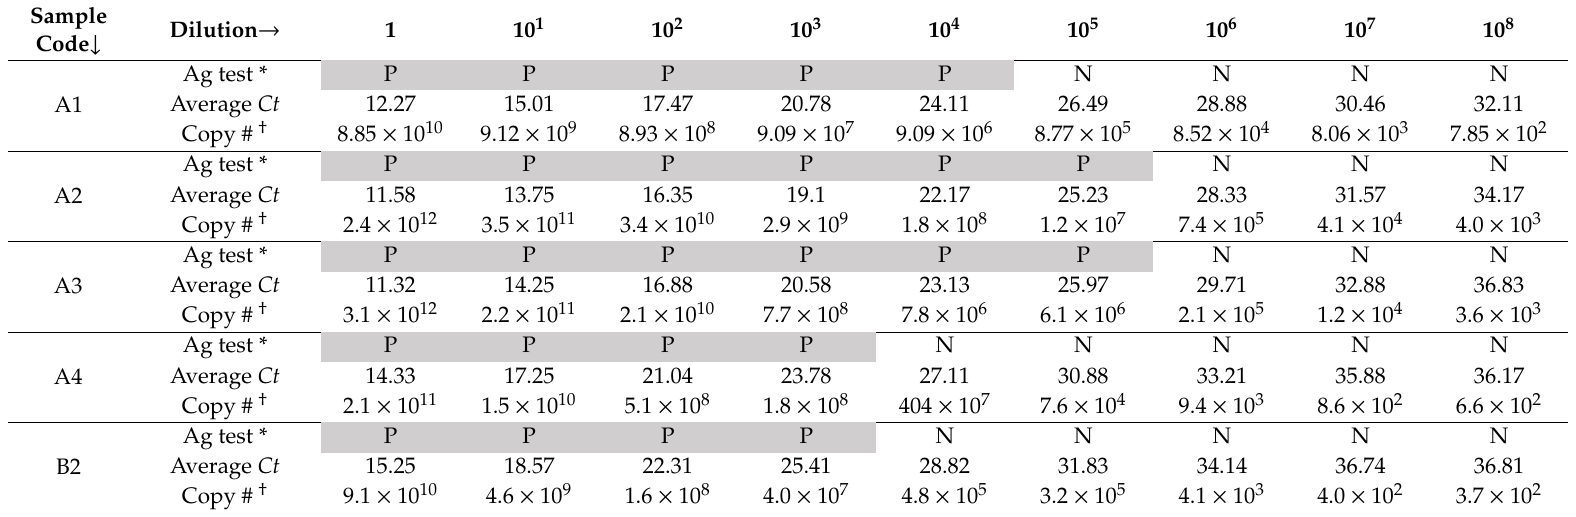
Table 3. Test results of antigen detection test compared with qPCR determined by testing serial dilutions of faecal samples.